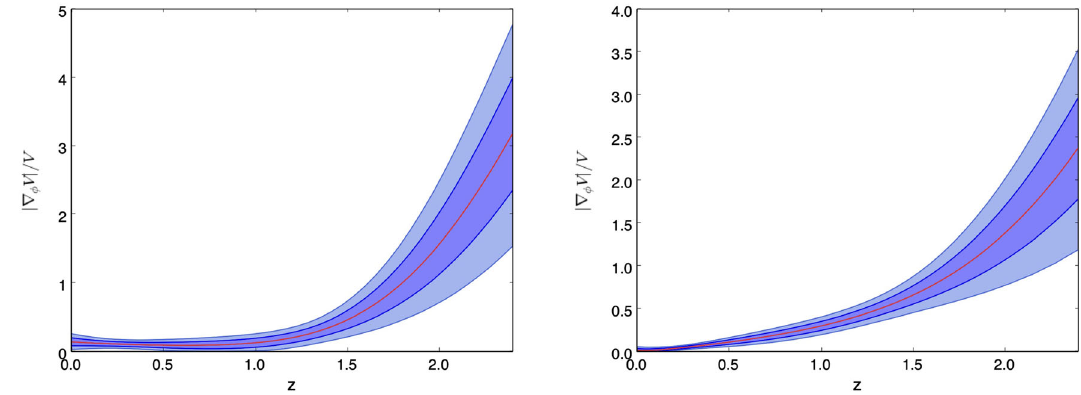
Fig. 8 The GP reconstruction of | V (cid:3) | / V , Eq. (29), for the 30 H ( z ) samples deduced from the differential age method with 10 additional samples obtained from the radial BAO method (Table 1) are presented on the left hand side plot, when H 0 = 73 . 52 ± 1 . 62 km s − 1 Mpc − 1 has been merged to the expansion rate data used in the GP. The right hand side plot represents the GP reconstruction of | V (cid:3) | / V , Eq. (29), when